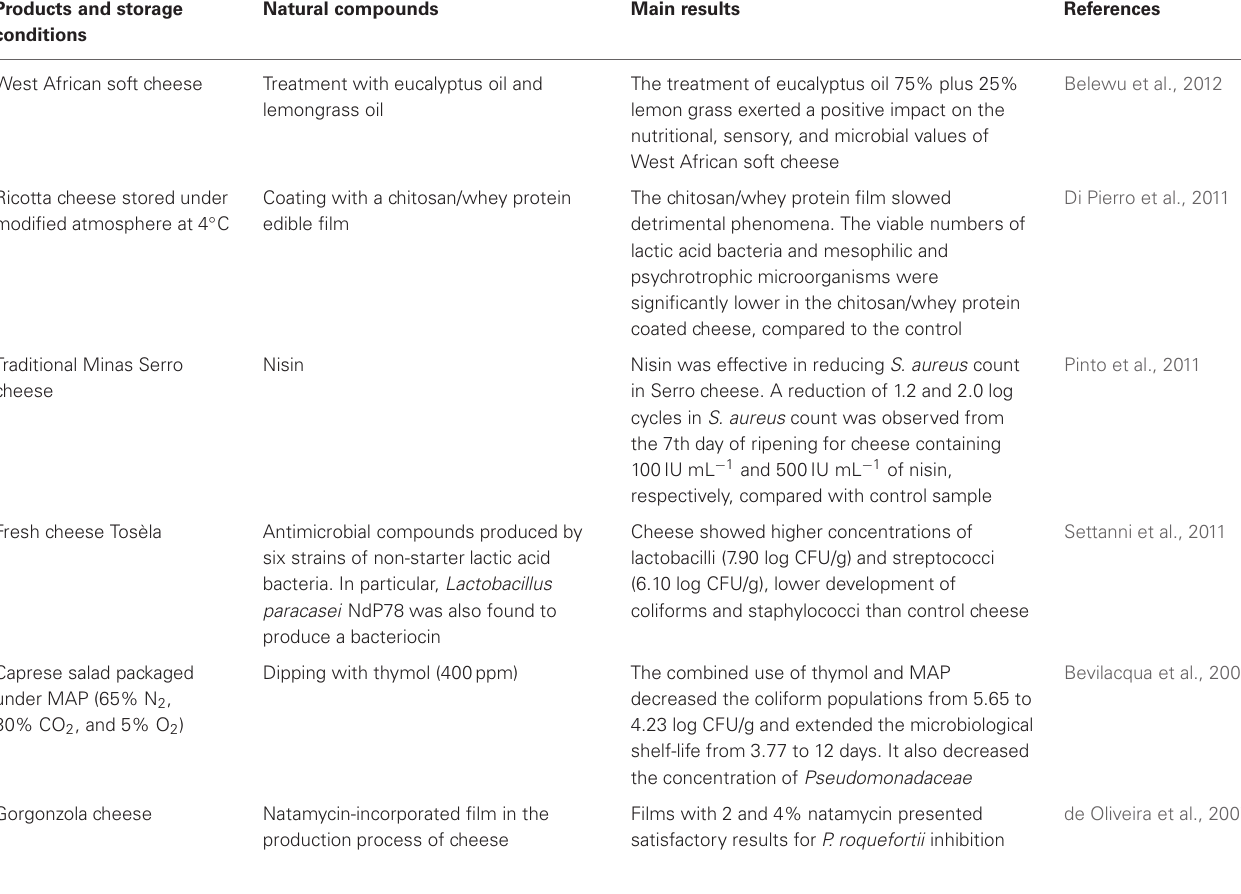
Table 2 | Relevant examples of natural active compounds applied to dairy